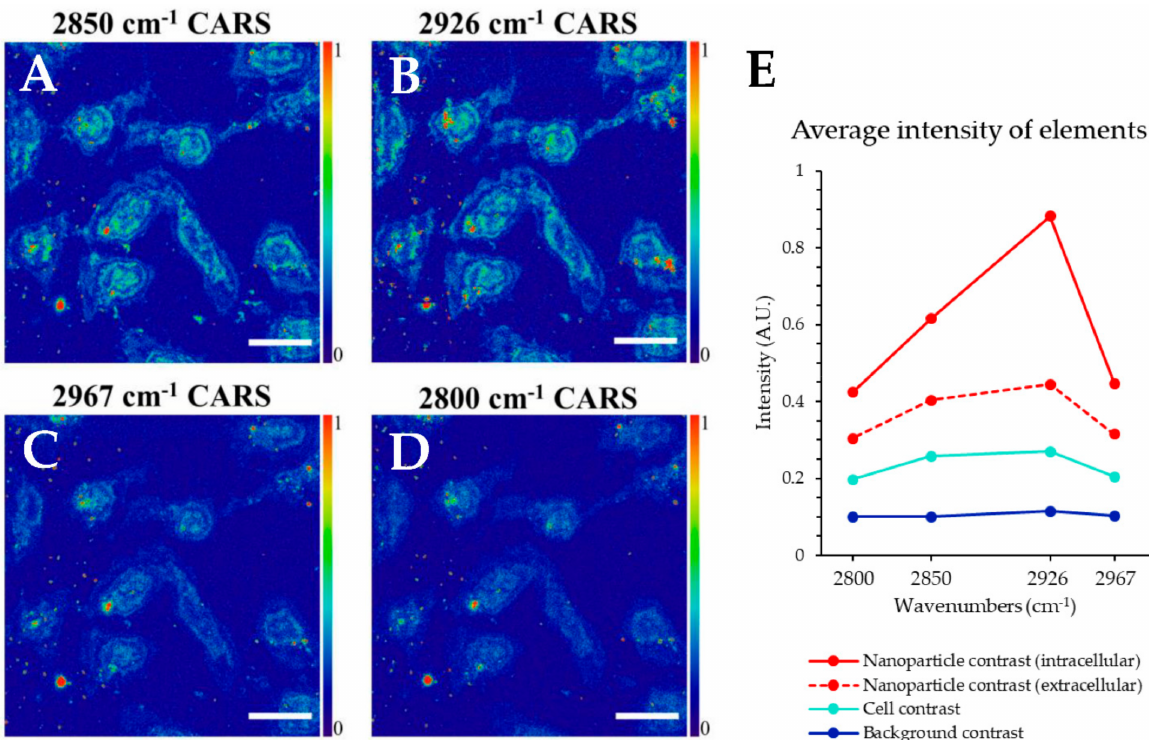
Figure 4. Series of epi-CARS images of magnetic-plasmonic nanoparticles uptaken in GR-KLM − 1 cells at 2850 cm − 1 , 2926 cm − 1 , 2967 cm − 1 , and 2800 cm − 1 . All scale bars are 20 µ m. ( E ) shows the average intensity of the various image elements for the different CARS wavenumbers with error bars indicating one standard deviation in a population of 10 measurements. Solid and dotted trendlines have been added to aid